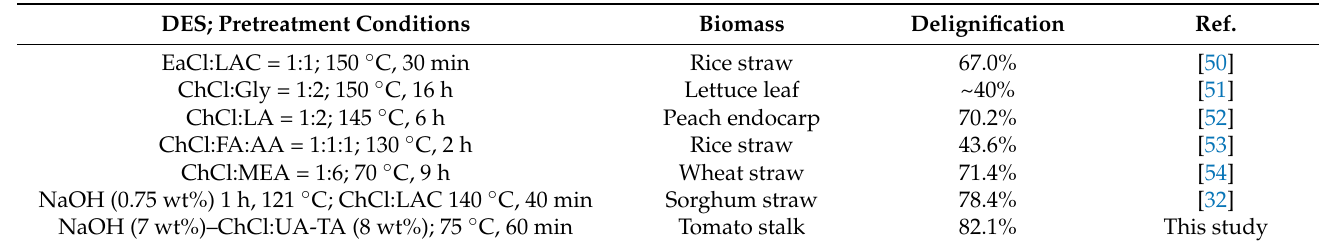
Table 1. Related works about DES pretreatment of biomass.